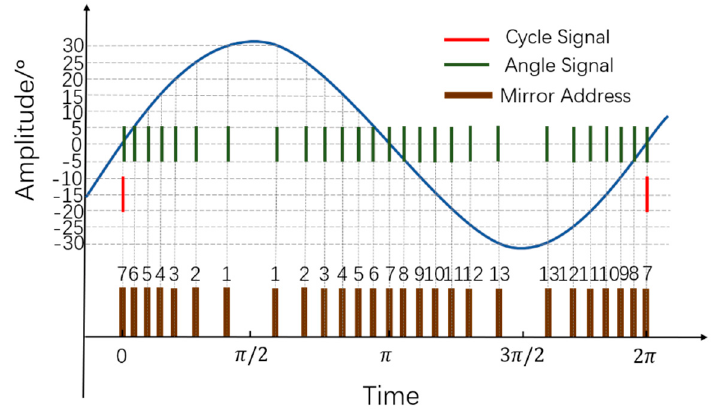
Figure 2. Position signals of the uniaxial MEMS mirror (angular resolution is 5° and optical scanning angle is 60°).